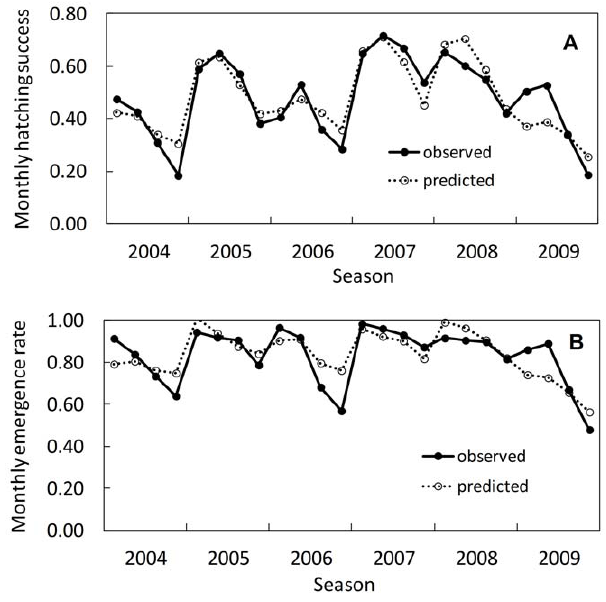
Figure 2. Hatching success and emergence rate of leatherback nests at Playa Grande, between 2004–2005 and 2009–2010. (a) Observed versus predicted mean monthly hatching success. Prediction was based on local weather conditions ( y=a + bx 1 + cx 2 2 dx 3 ; R 2 =0.81, P , 0.001); where x 1, x 2 and x 3 were precipitation accumulated in the two previous months, precipitation in October and mean ambient temperature during incubation respectively. Regression coefficients ( 6 SE) were a = 1.87 6 0.76, P , 0.05; b = 1.83 6 10 2 4 6 4.94 6 10 2 5